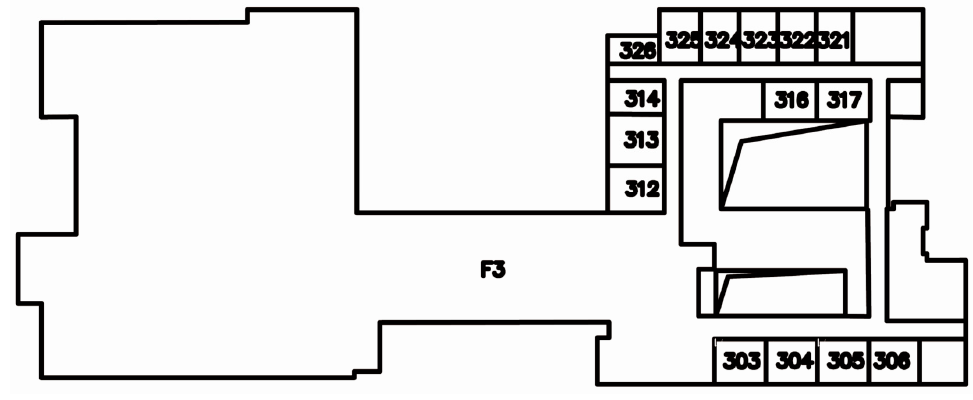
Figure 2. Typical floor plan of project YL.